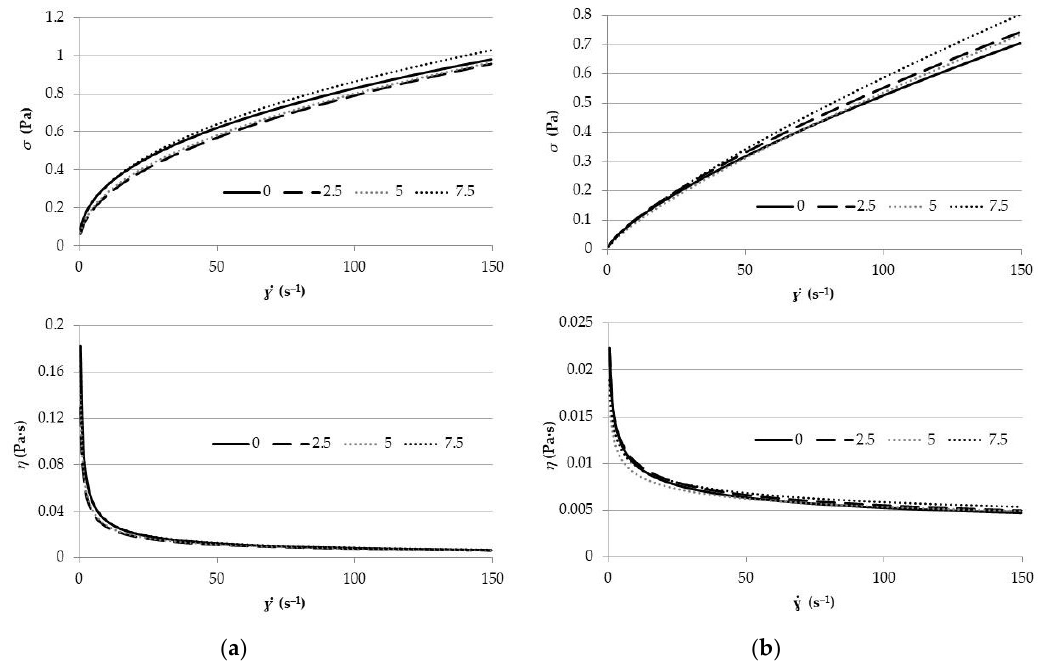
Figure 4. ( a ) Flow behaviour ( σ - γ ) and viscosity profiles ( η - γ ) of pasteurised orange juice with pulp (OJP); ( b ) Flow behaviour ( σ - γ ) and viscosity profiles ( η - γ ) of pasteurised orange juice without pulp (OJWP).